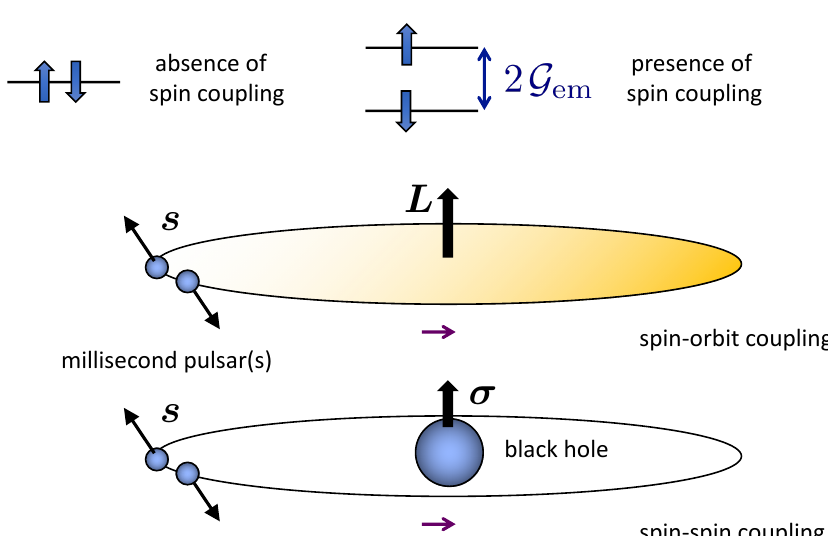
Figure 7. Schematic illustrations of the splitting of the gravito-magnetic correction factors (given by 2 ) in the presence of angular-momentum couplings. The interaction between the spin and G em L ), and the interaction between the spins of the MSP and the orbit of the MSP is proportional to ( s · σ ). There will be different gravito-magnetic correction factors for the the BH is proportional to ( s · parallel and the anti-parallel states, giving rise to a relative time dilation between the two states measured by a distant